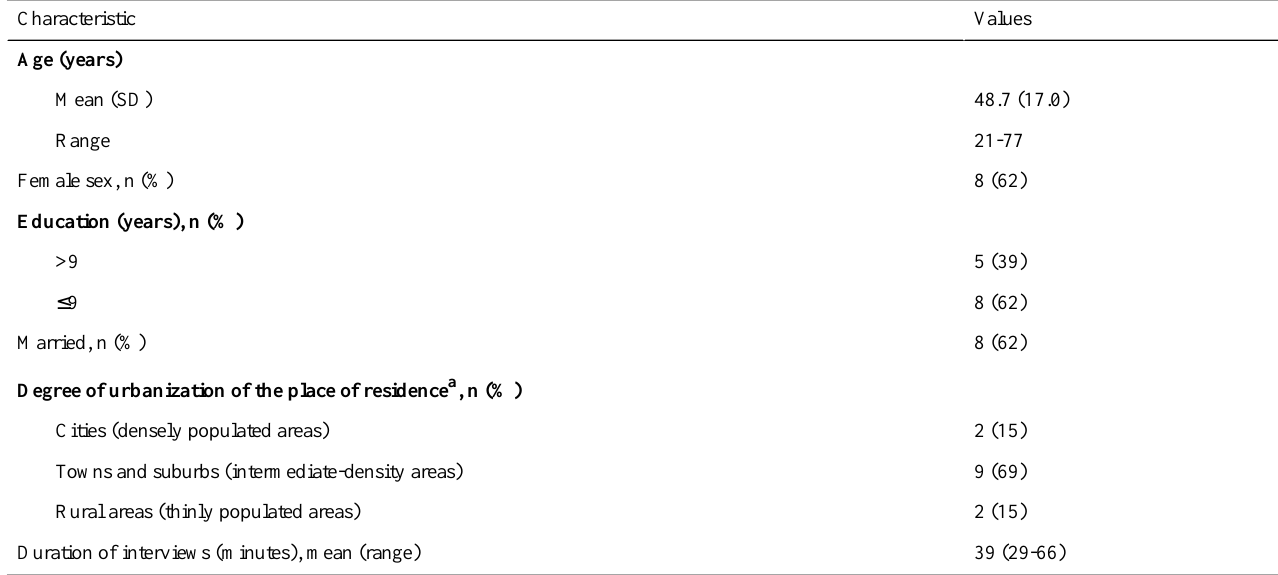
Table 1. Sample description (N=13).